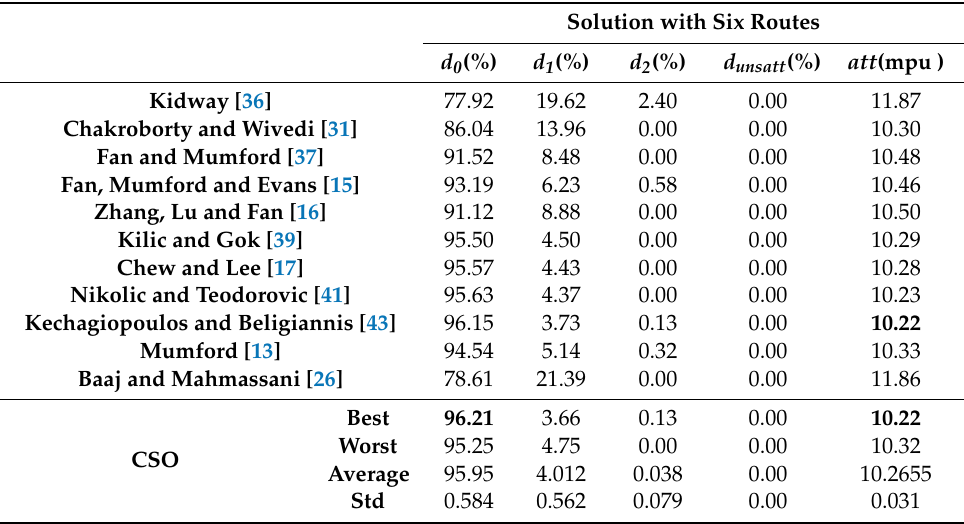
Table 6. Comparative results for the best six-route solutions for Mandl’s